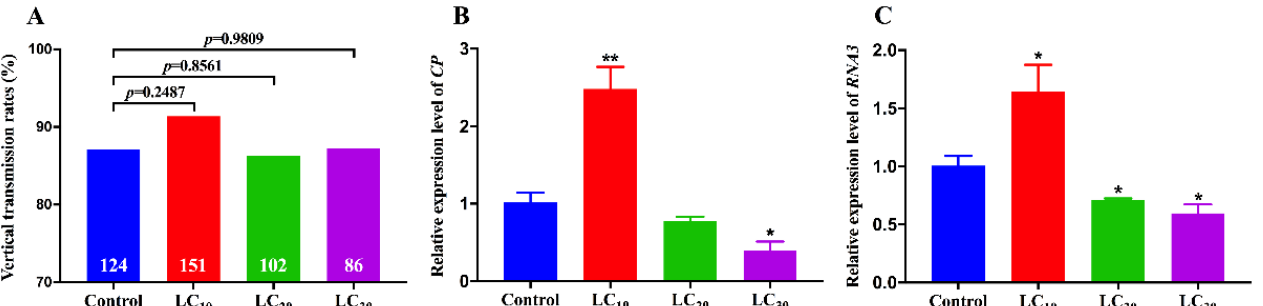
Figure 5. Effects of imidacloprid on RSV transmission of the viruliferous SBPH. ( A ) The vertical transmission rates of RSV in the viruliferous SBPH after treatment with sublethal concentrations of imidacloprid. Relative expression levels of RSV CP ( B ) and RNA3 ( C ) in the ovaries of SBPH. Chi-square ( χ 2 ) test was used to analyze the data of vertical transmission rates ( A ). The white figure at the bottom of the column shows the total sample size of each treatment. The asterisk in ( B , C ) indicates significant differences between the treatment and the control (Student’s t -test, * p < 0.05, ** p < 0.01).